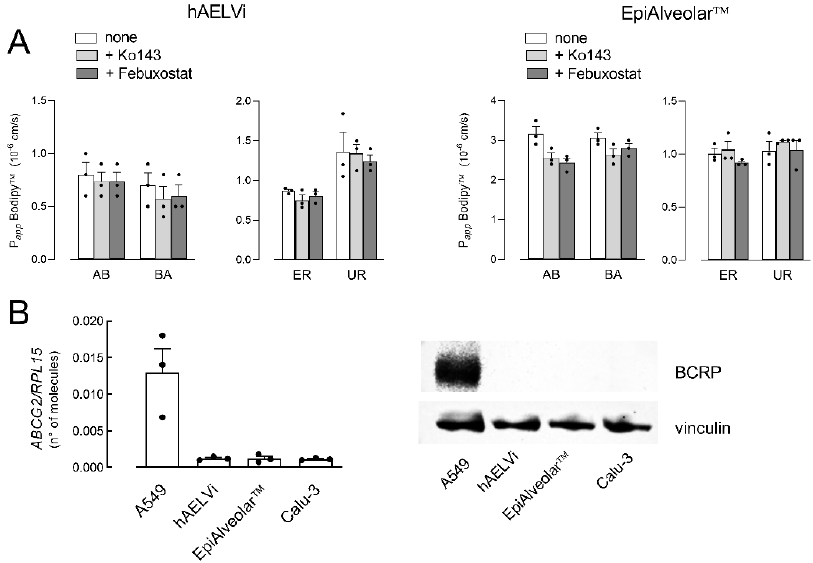
Figure 3. Expression and activity of ABCG2 /BCRP. Panel ( A ): The apical-to-basolateral (AB) and basolateral-to-apical (BA) fluxes of 3 µ M Bodipy™ FL Prazosin were monitored both in the absence (none) and in the presence of 20 µ M Ko143 and 50 µ M Febuxostat, as indicated. Data obtained were employed to calculate the efflux ratio (ER) and uptake ratio (UR), as defined in Materials and Methods. Bars are the mean ± SEM of 3 independent determinations (single dots). Panel ( B ): The expression of ABCG2 /BCRP gene and protein were performed with RT-qPCR and Western blot analyses, respectively, as described in Materials and Methods. Data of mRNA expression are the mean ± SEM of 3 independent determinations (single dots), while a representative Western blot is shown that, repeated twice, gave comparable